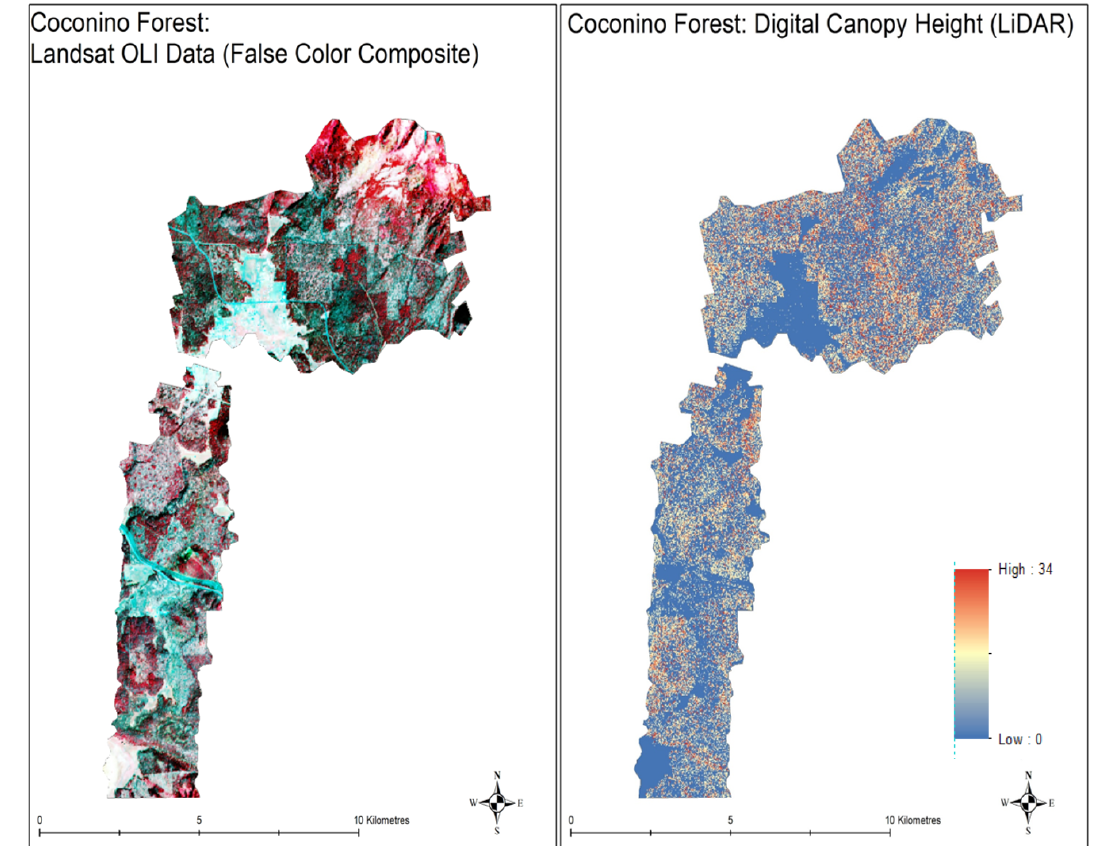
Figure 1. Map of study area. The left image is the false composite image of area under study and the right image is the digital canopy height generated from the light detection and ranging (LiDAR) data obtained from OpenTopography [41]. The Landsat data not only contain 11 bands of Landsat 8 but also contain 19 normalized and direct band